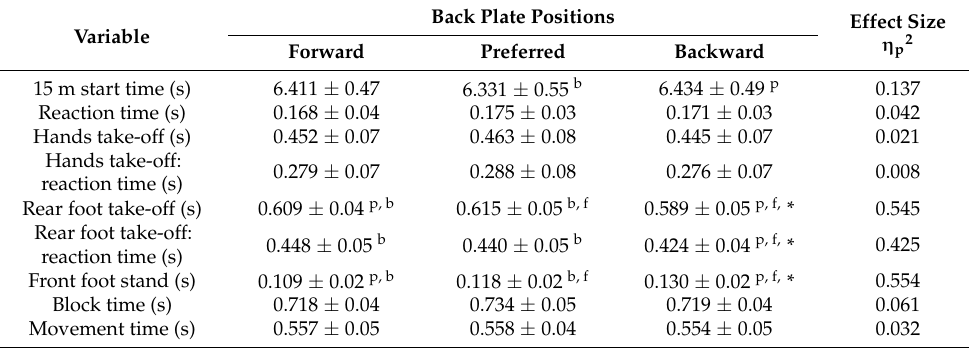
Table 3. Mean ± SD of the temporal variables of swimming start performed by male swimmers presented separately for each starting position and complemented with significant results exposed through statistical